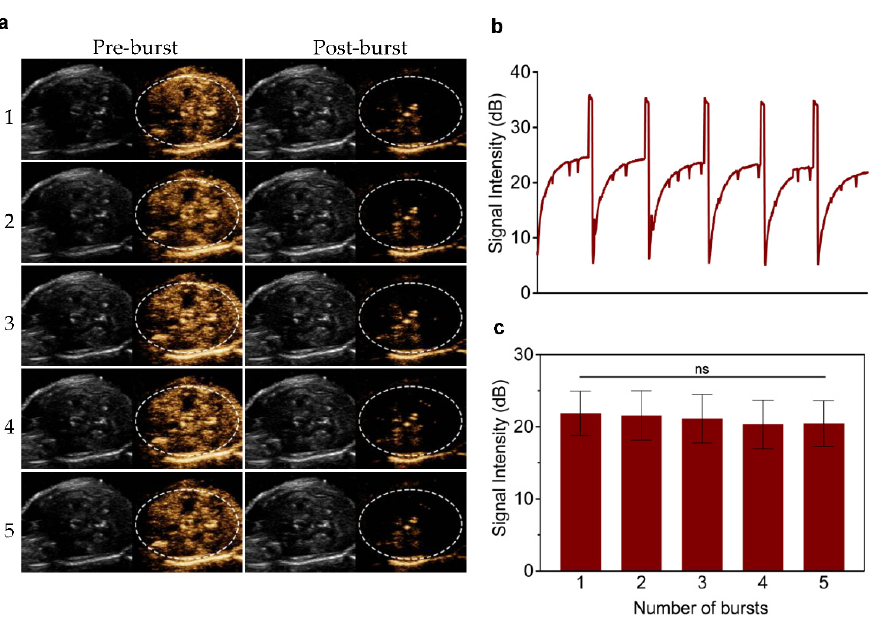
Figure 4. Re-perfusion of GVs after multiple ultrasonic bursts in vivo: ( a ) B-mode and nonlinear contrast images of GVs’ re-perfusion process after five ultrasonic bursts, about 30 s between two bursts ( b ) time–intensity curve of contrast signals of GVs during five ultrasonic bursts; ( c ) contrast signal intensities produced by the re-perfusion of GVs after each burst. Error bars represent ± SD. ns, no statistical significance.